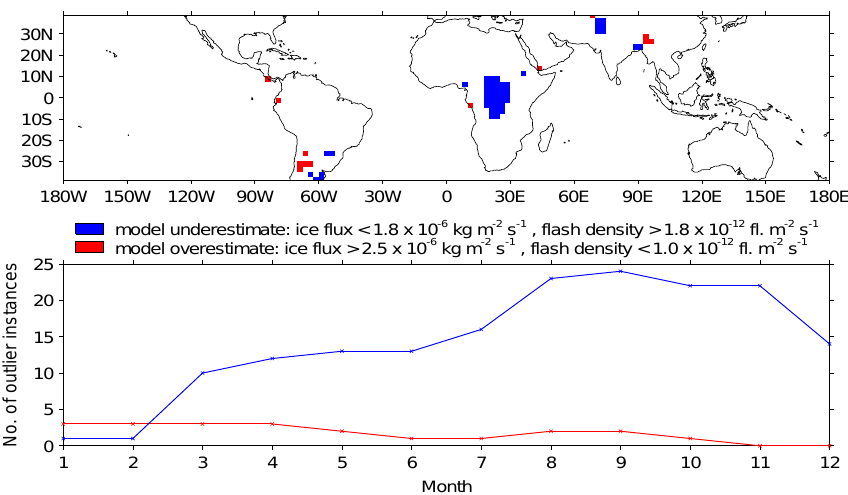
Figure 3. Continental regions that would be under- or over-estimated with the proposed ice flux parametrisation. Under-estimation in blue and over-estimation in red. Any coloured cell in the figure contains at least one month of large under- or over-estimation. Shown at the bottom is the number of cells of under- or over-estimation in each month. Under- and over-estimation are defined as scatter points in Fig. 2 in the axis ranges of y axis > 1 . 8 × 10 − 12 fl.m − 2 s − 1 , x axis < 1 . 0 × 10 − 6 kg ice m − 2 s − 1 and y axis < 1 . 8 × 10 − 12 fl.m − 2 s − 1 , x cell cloud cell